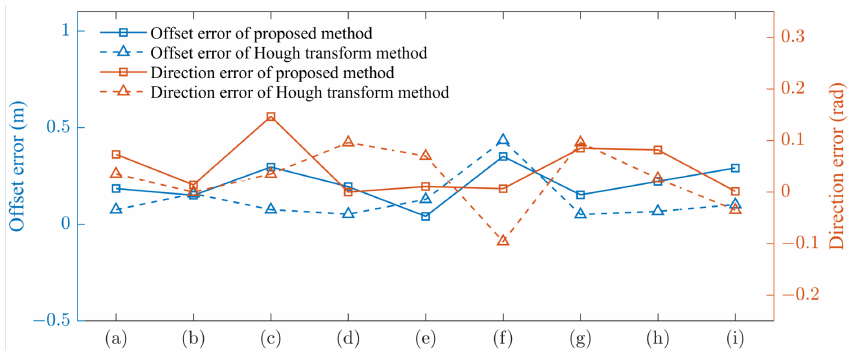
Figure 15. The offset error and direction error of different methods corresponding to ( a – i ) in Figure 14.